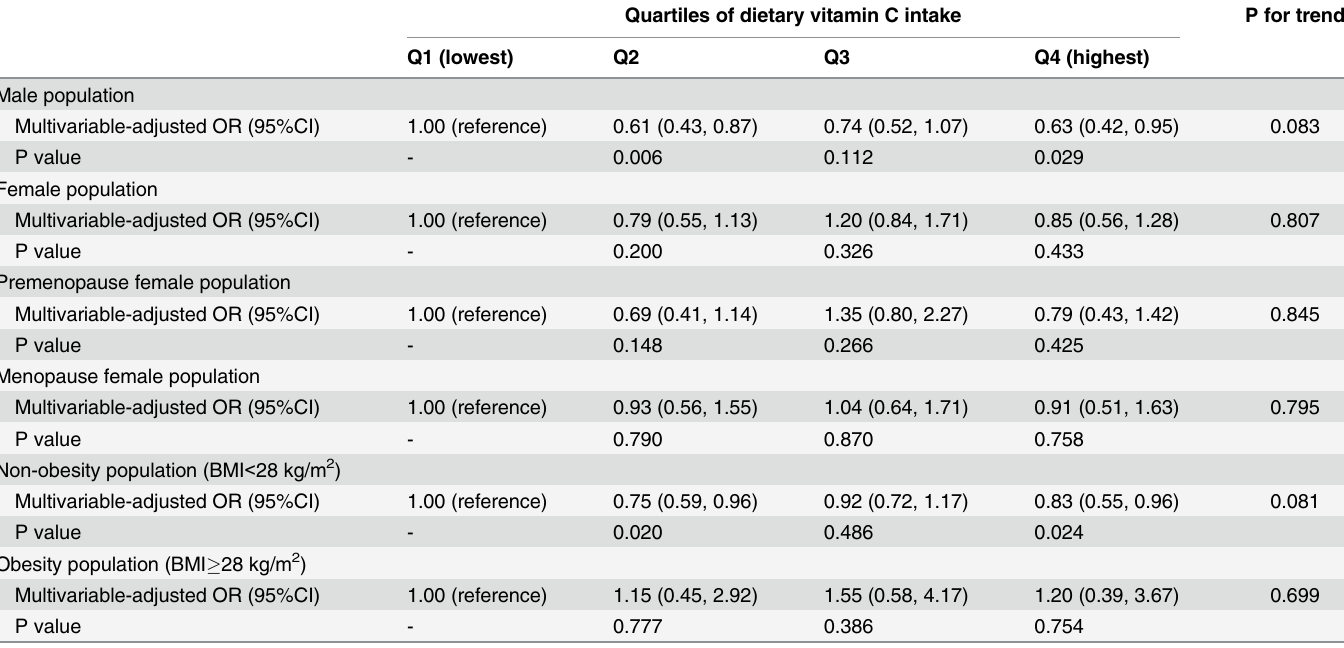
Table 3. Subgroup analysis of multivariable-adjusted relationship between dietary vitamin C intake and NAFLD. Quartiles of dietary vitamin C intake P for